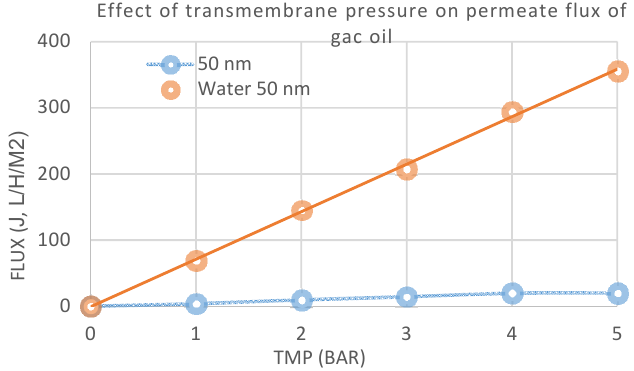
Figure 15. Effect of transmembrane pressure on permeate flux of gac oil ( T = 30 °C; Membrane pore size = 100 nm).